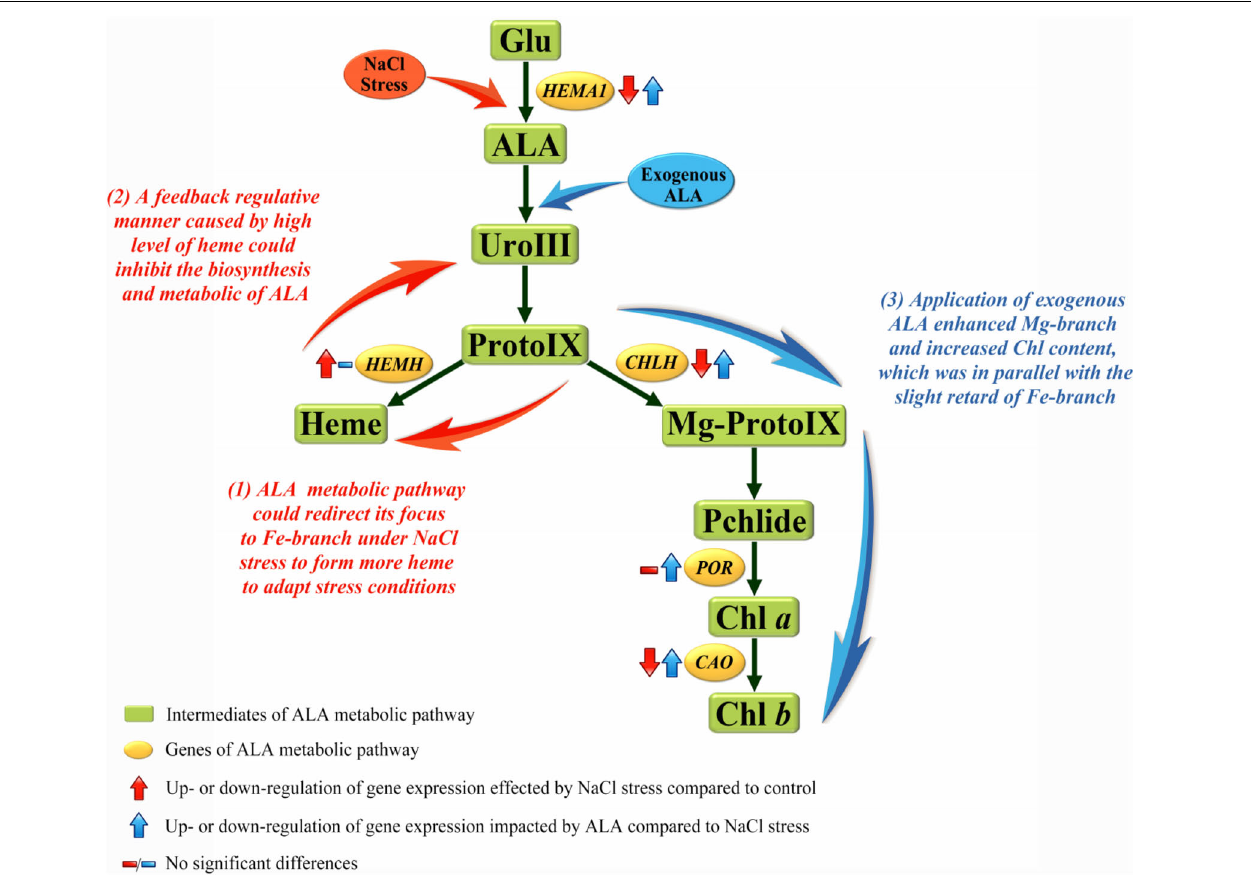
FIGURE 8 | Regulation manners among ALA metabolic pathway of cucumber under NaCl stress. The metabolic pathway downstream of ALA in higher plants can mainly fall into Fe-branch and Mg-branch, for heme biosynthesis and chlorophyll biosynthesis, respectively. Results showed that (1) Fe-branch was enhanced under salt stress to form more heme, this could be conjectured as an adaptive or against response in plants; (2) The accumulation of heme under stress condition feed-back inhibited the biosynthesis and metabolic of endogenous ALA; (3) Application of exogenous ALA under stress enhanced the Mg-branch to produce more chlorophyll and kept the Fe-branch enhanced at the same